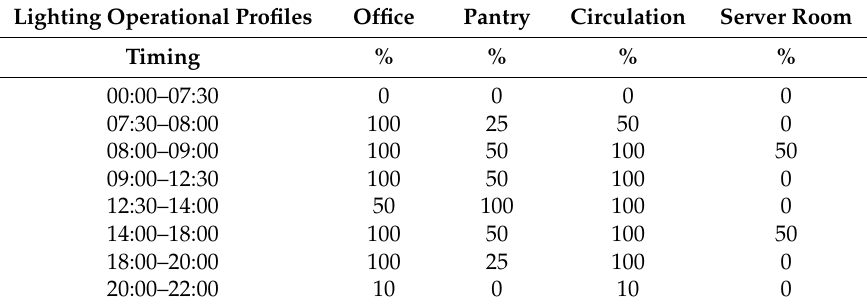
Table 4. Lighting operational profiles.